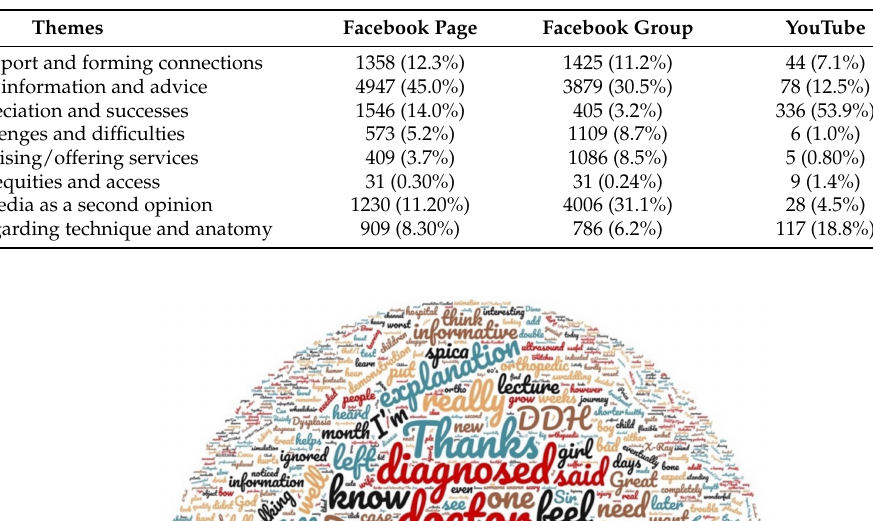
Table 2. Distribution of comments across, by theme.